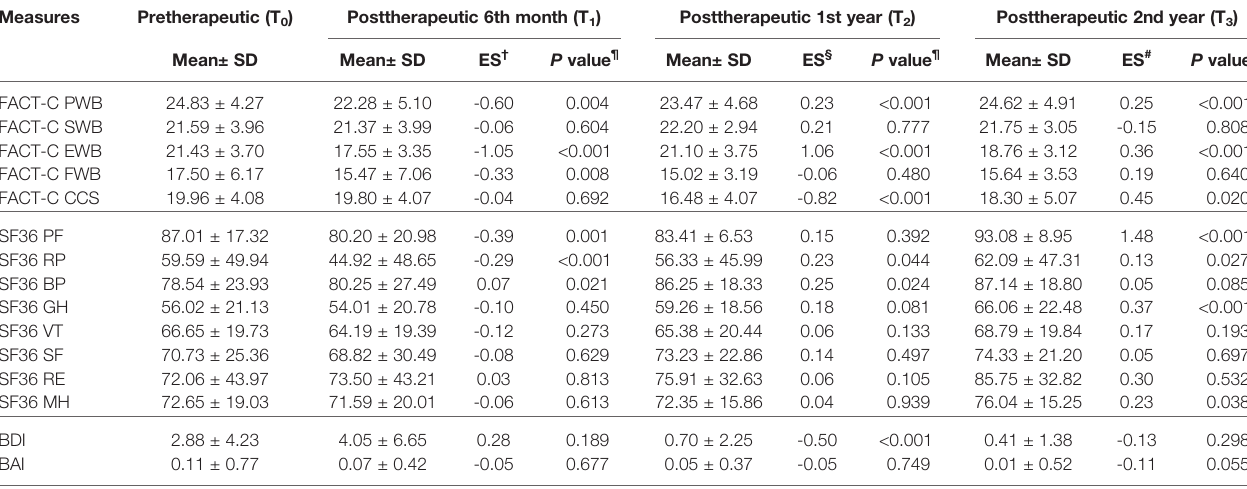
TABLE 2 | Paired t test was employed to evaluate trends of the FACT-C, BDI, BAI, and SF-36 in the study group in patients with metastatic colorectal cancer at different time points ( N =75).